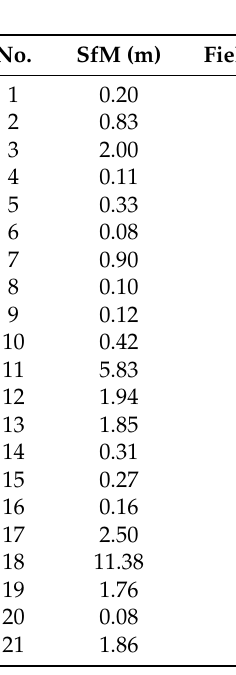
Table 4. The measurement result of several object (layer thickness, outcrop’s height, or fault offset) based on the SfM model and field